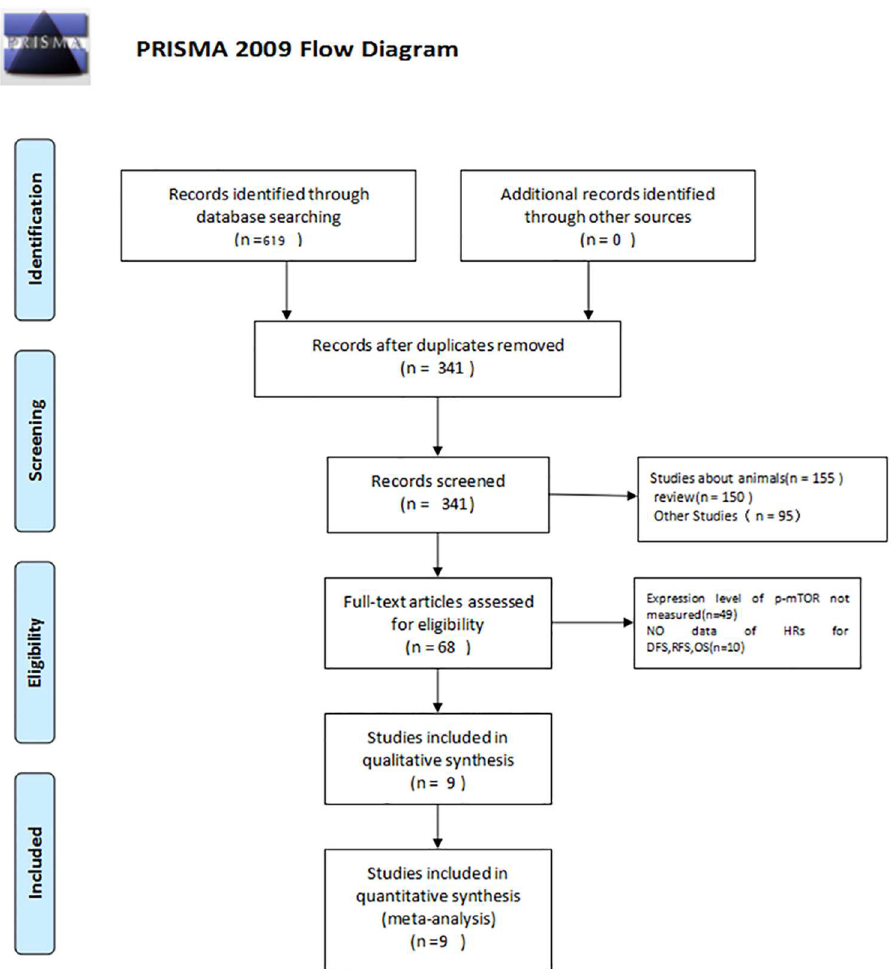
Fig 1. Flow diagram of study